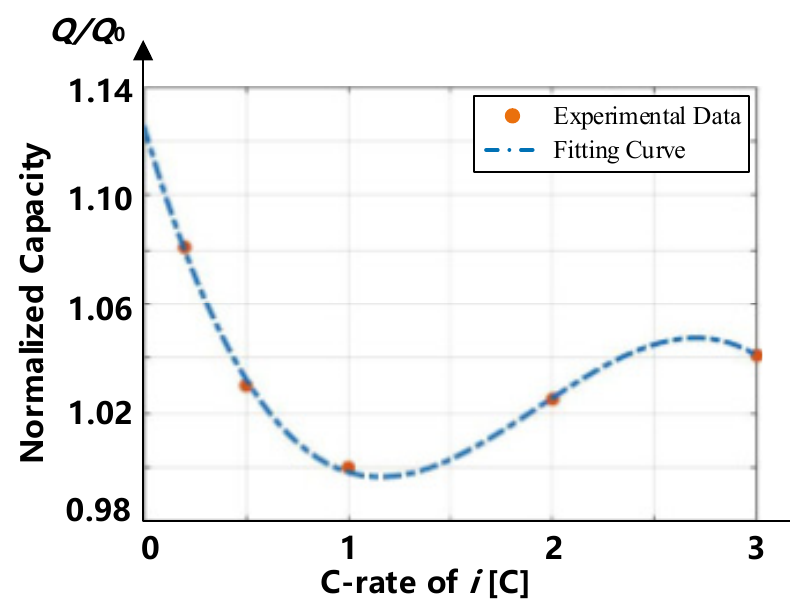
Figure 6. Normalized capacity curve as a function of i [29].